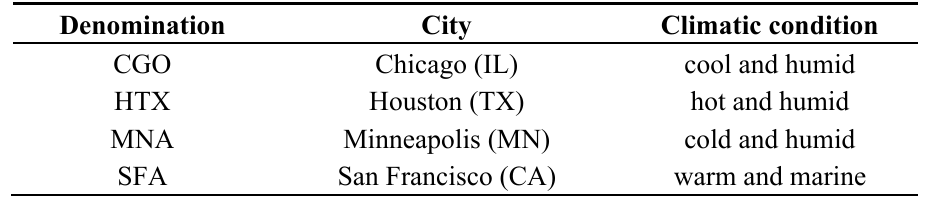
Table 4. Climates investigated for sensitivity